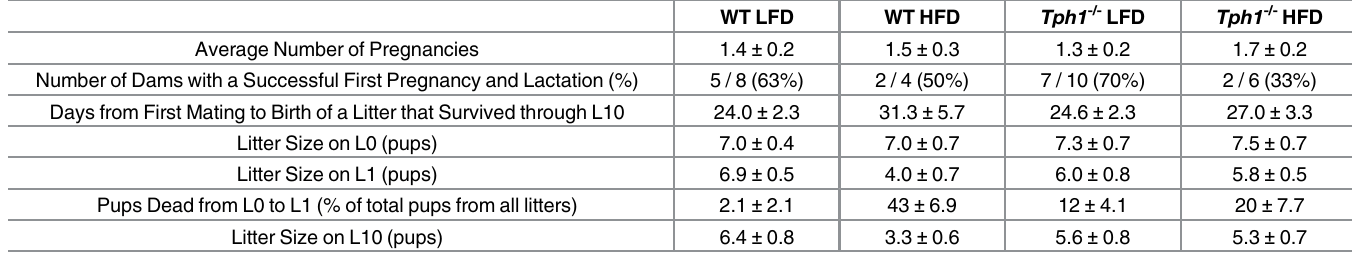
Table 3. Dam Pregnancy and Litter Mortality